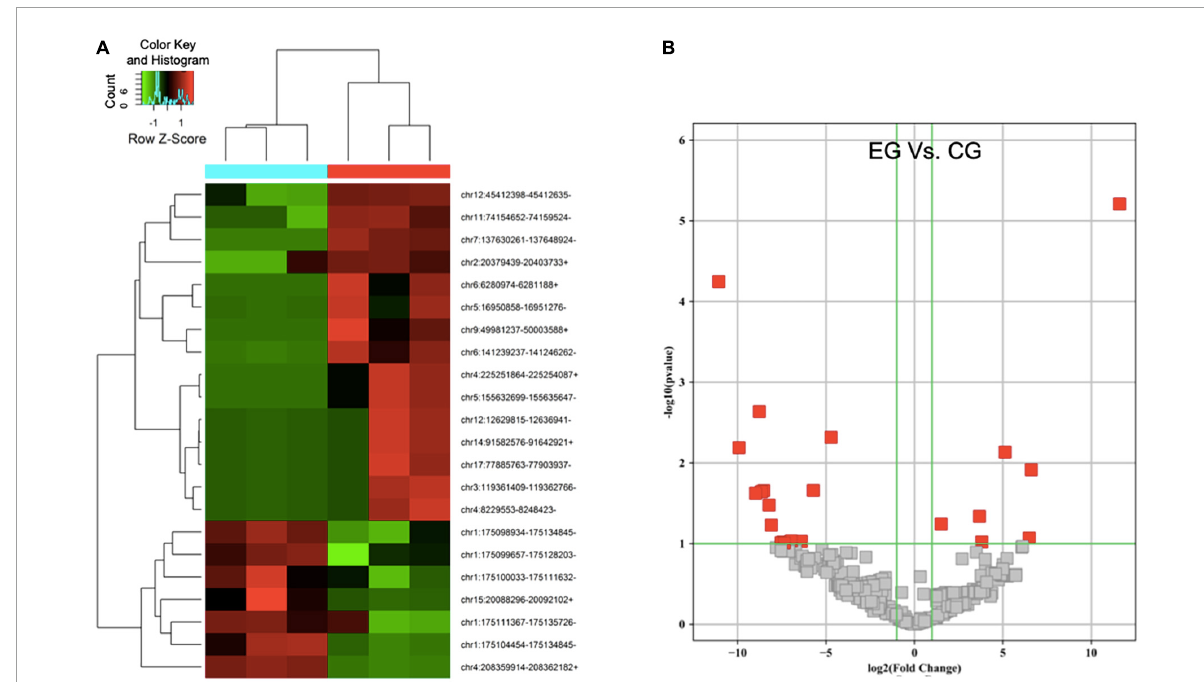
FIGURE2 The expression profile of differentially expressed circular RNAs (circRNAs) in spinal cord injury (SCI) rats is identified. (A) Heat map of differentially expressed circRNAs from circulating exosomes. (B) Two-dimensional presentation for cluster analysis of differentially expressed circRNAs from circulating exosomes. Red represents relatively high expression, green represents relatively low expression, and black represents the average expression. P < 0.05, fold change > 2.0.